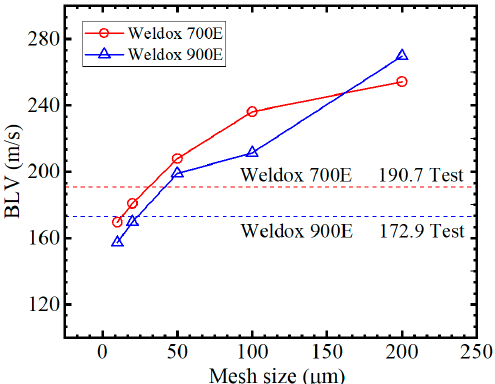
Figure 15. Curves of BLV with mesh size for Weldox 700 E [30] and Weldox 900 E steels calculated using the JC fracture criterion.